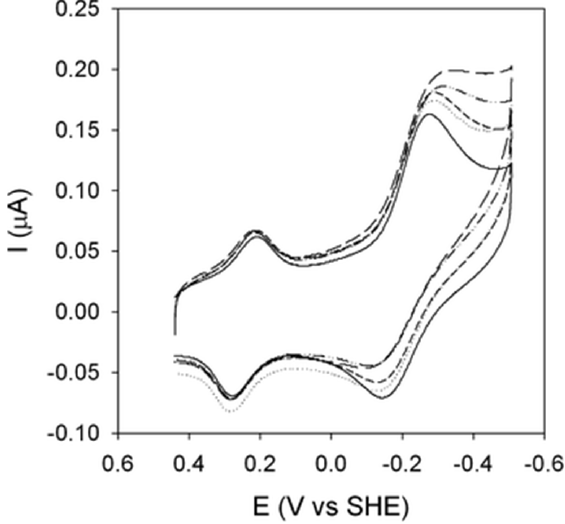
Figure 5. Cyclic voltammograms for a K72A/K73H/K79A mutant of yeast cytochrome c adsorbed on polycrystalline gold electrode modified with a SAM of MUA/MU recorded in the presence of increasing concentrations of H 2 O 2 . For the solution composition and other experimental conditions, the reader is referred to the original literature. Reprinted with permission from ref. [15]. Copyright 2012 Royal Society of Chemistry.